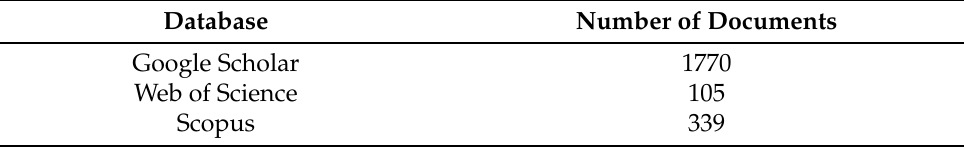
Table 1. Results provided by each